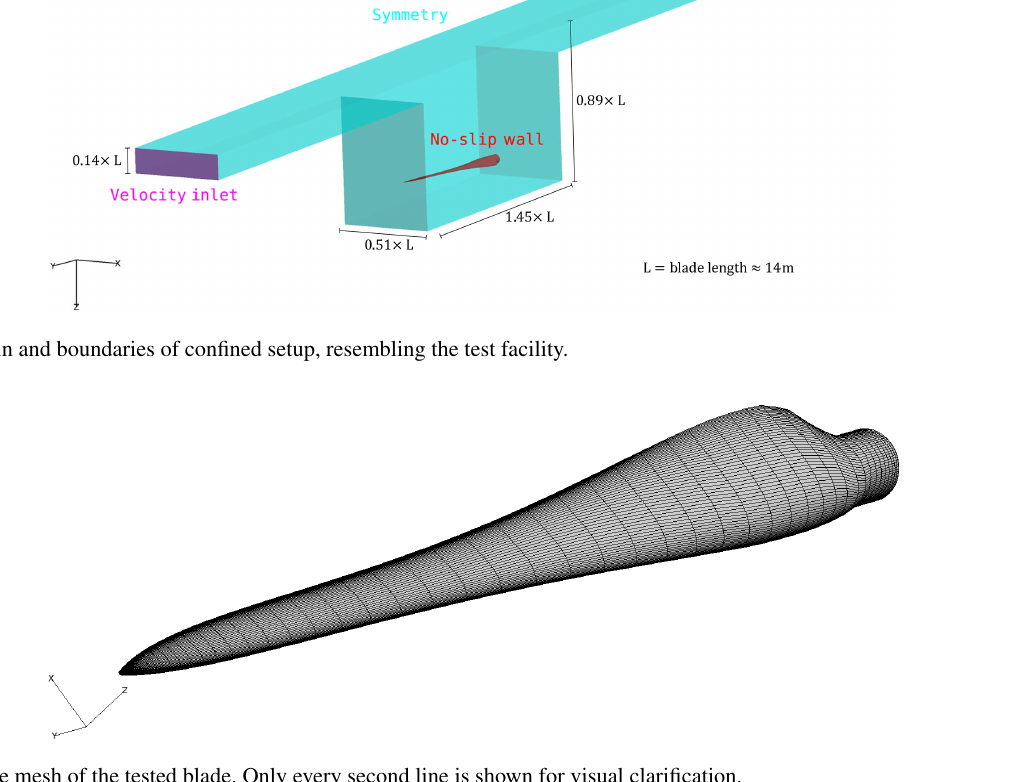
Figure 4. Surface mesh of the tested blade. Only every second line is shown for visual clarification.